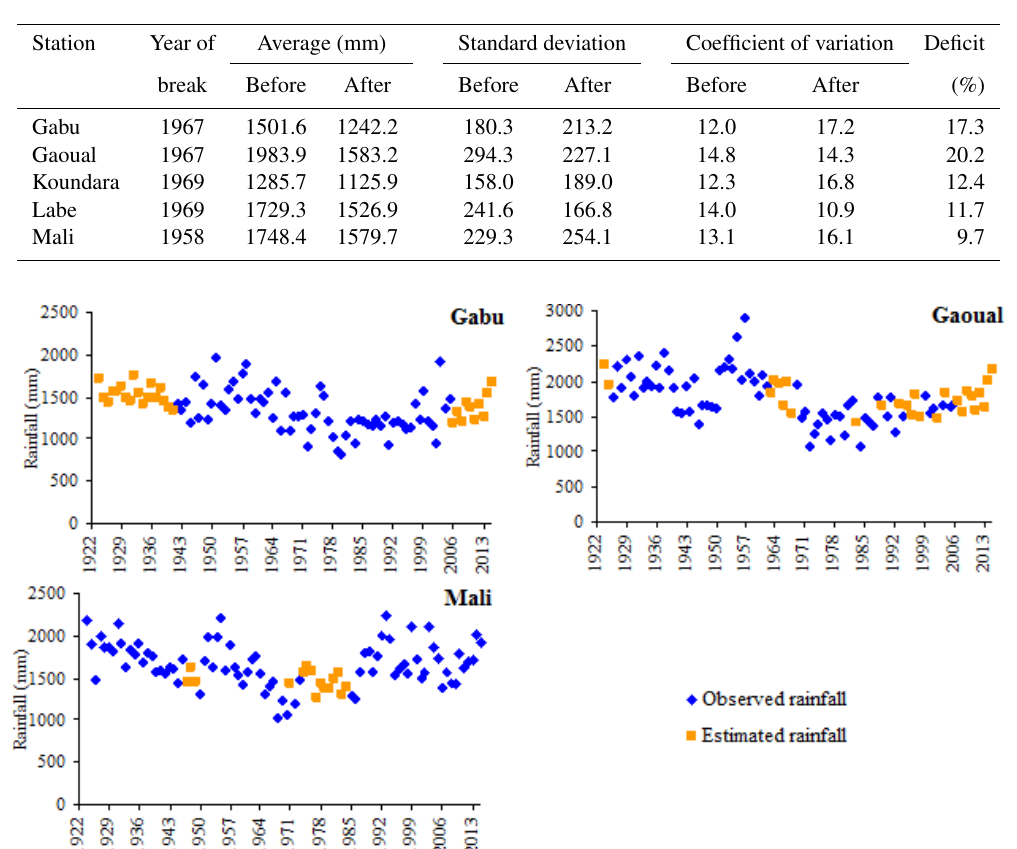
Table 4. Synthesis of the results of Pettitt test.